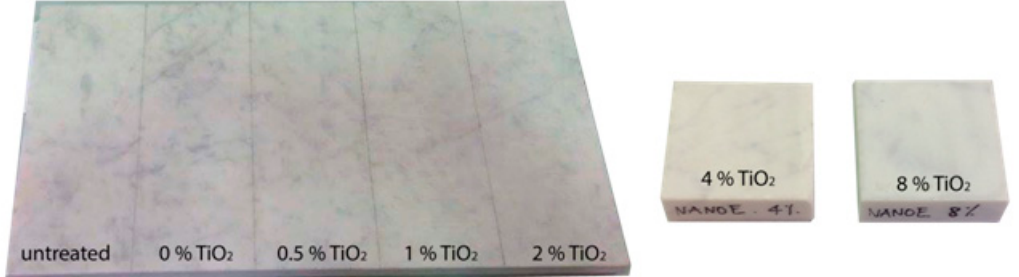
Figure 1. Marble samples covered by NANOESTEL, whit increasing weight percentage of titanium dioxide (TiO 2 ). For untreated material and TiO 2 amount up to 2 w%, the samples were obtained dividing into 40 cm × 20 cm sections the same slab; whereas, for 4 w% and 8 w% other two samples of 5 cm × 5 cm were